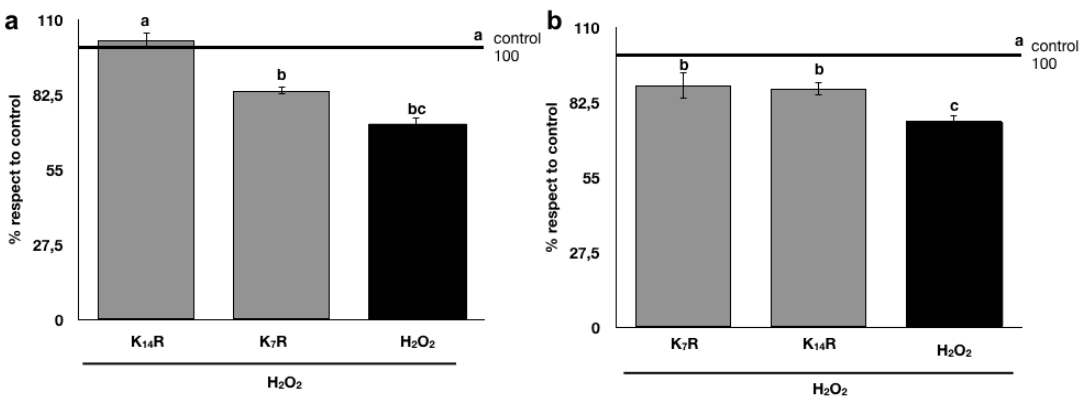
Figure 6. L929 cell proliferation after oxidative stress: ( a ) “Curative model” and ( b ) “Preventive model”. Data, expressed as % of control, represent mean ± 2 SEM of three independent experiments. Statistical analysis of differences was carried out by two-way ANOVA followed by Fisher’s LSD as post-hoc test. Different letters represent statistical significance: ( p ≤ 0.05).